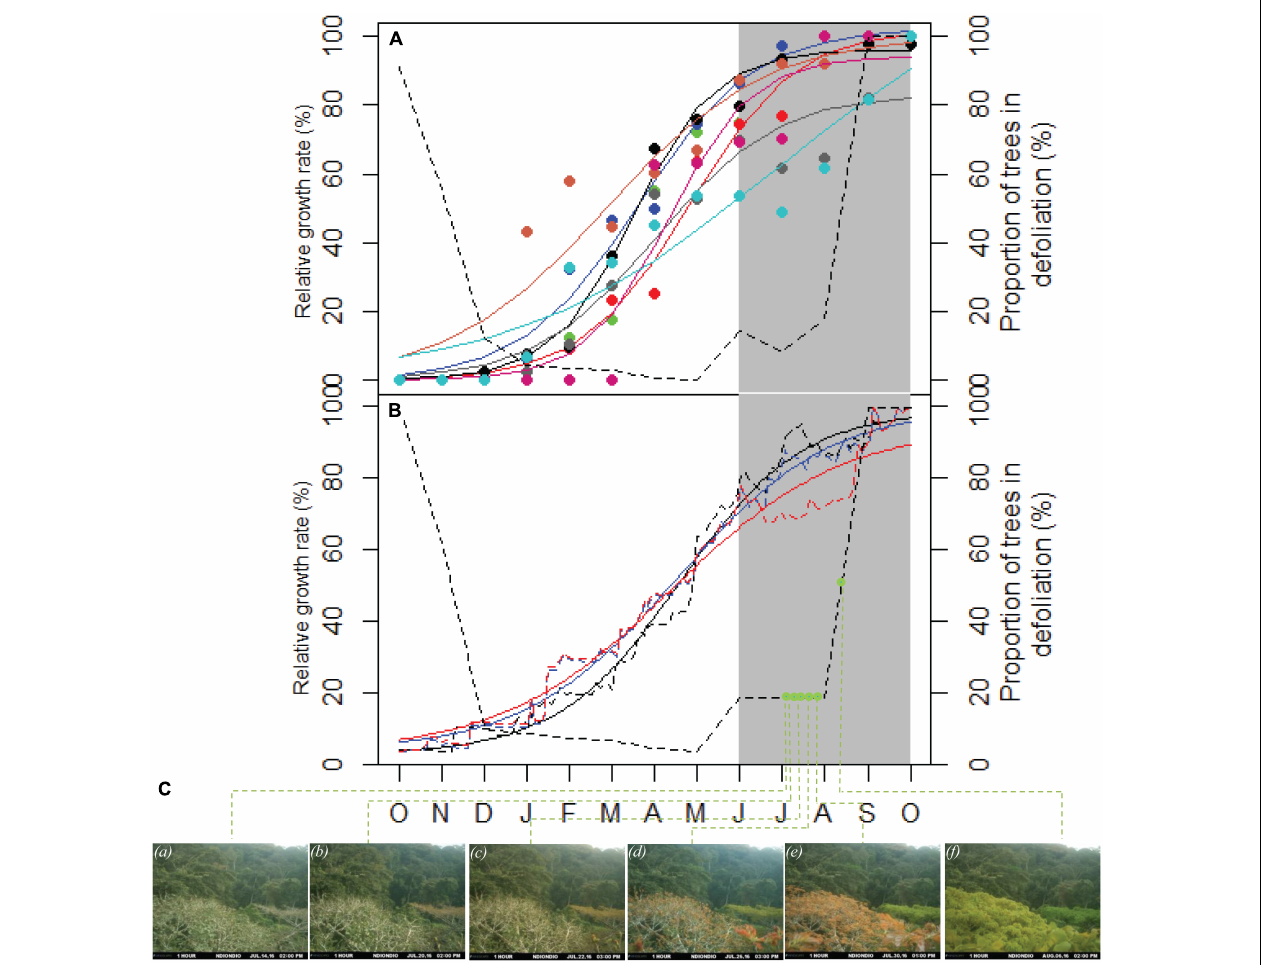
FIGURE 2 | Intra-annual growth dynamics of Prioria balsamifera: (A) lines represent the Gompertz fit based on circle points that indicate the growth measurement based on cambial pinning of 10 trees monitored from 2006 to 2007 ( n = 10 trees). The dashed black line indicates time series of defoliation for 194 trees of P. balsamifera from 1947 to 1957. (B) The three lines represent the Gompertz fit assessed by point dendrometers from 2016 to 2017 ( n = 3 trees) and the dashed lines indicate the original series. The black dashed line shows the defoliation form time-lapse camera. The gray zone indicates the dry season. (C) The pictures from the time-lapse camera shows the development stages (a–f) during the onset of leafing in July/August